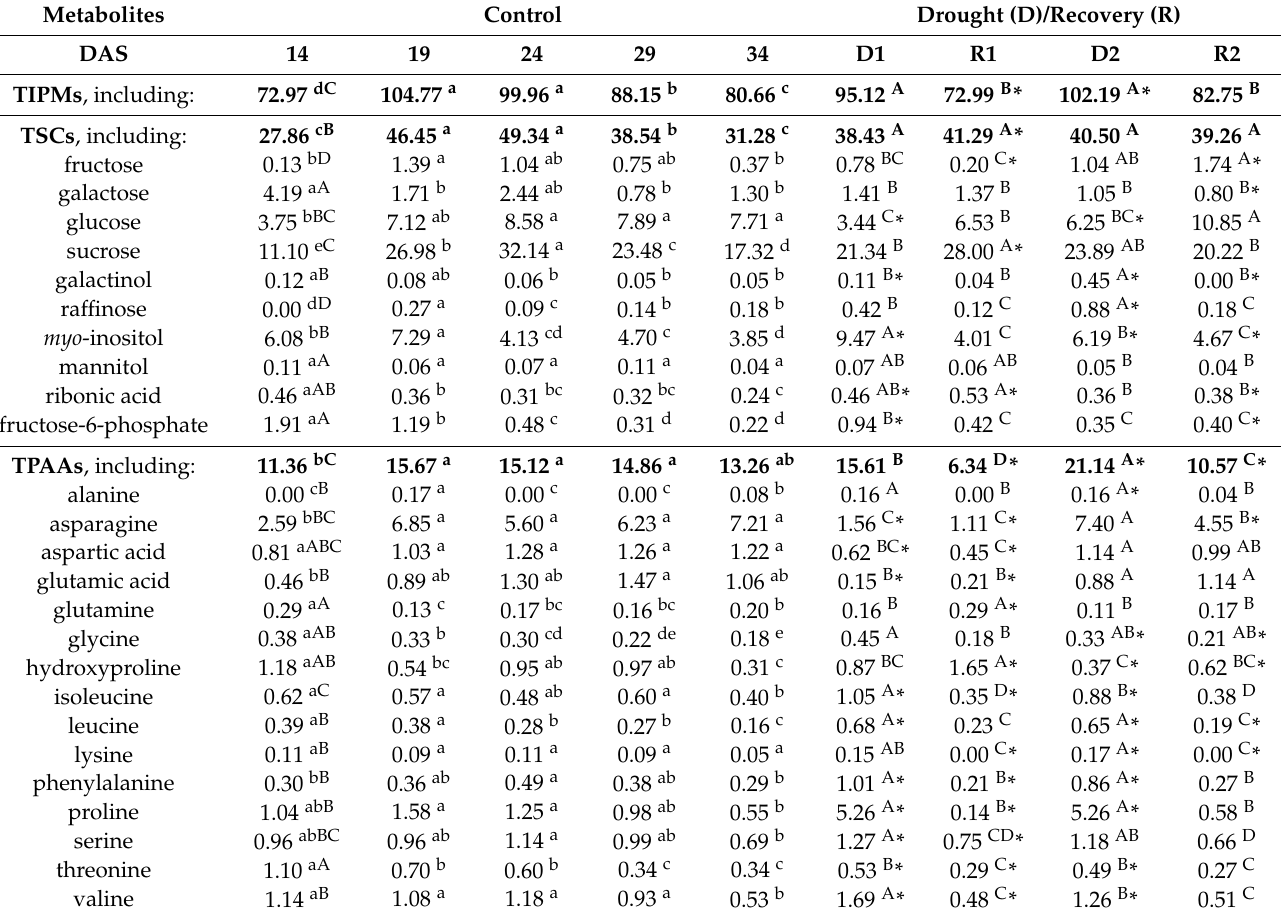
Table 1. The concentration of polar metabolites (in mg/g DW) in pea shoots ( Pisum sativum L., cv. Hubal) during 20 days of plant vegetation (from the 14th to the 34th day after sowing, DAS) at optimal soil moisture (control), after 5 days of watering withdrawal from 14th to 19th and from 24th to 29th DAS (drought, D1 and D2, respectively) and followed re-watering for 5 days, between 19–24 and 29–34 DAS (R1 and R2,